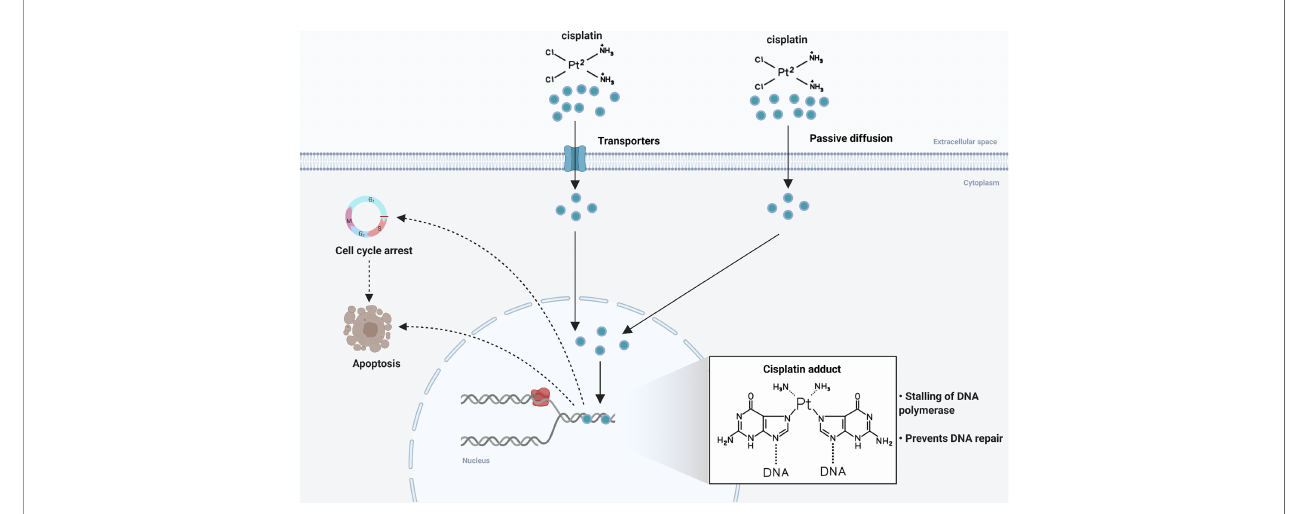
FIGURE 1 | Mechanism of action of cisplatin. Following entry into tumor cells by active transport or passive diffusion, cisplatin forms DNA adducts in the nucleus, leading to cell cycle arrest and cell